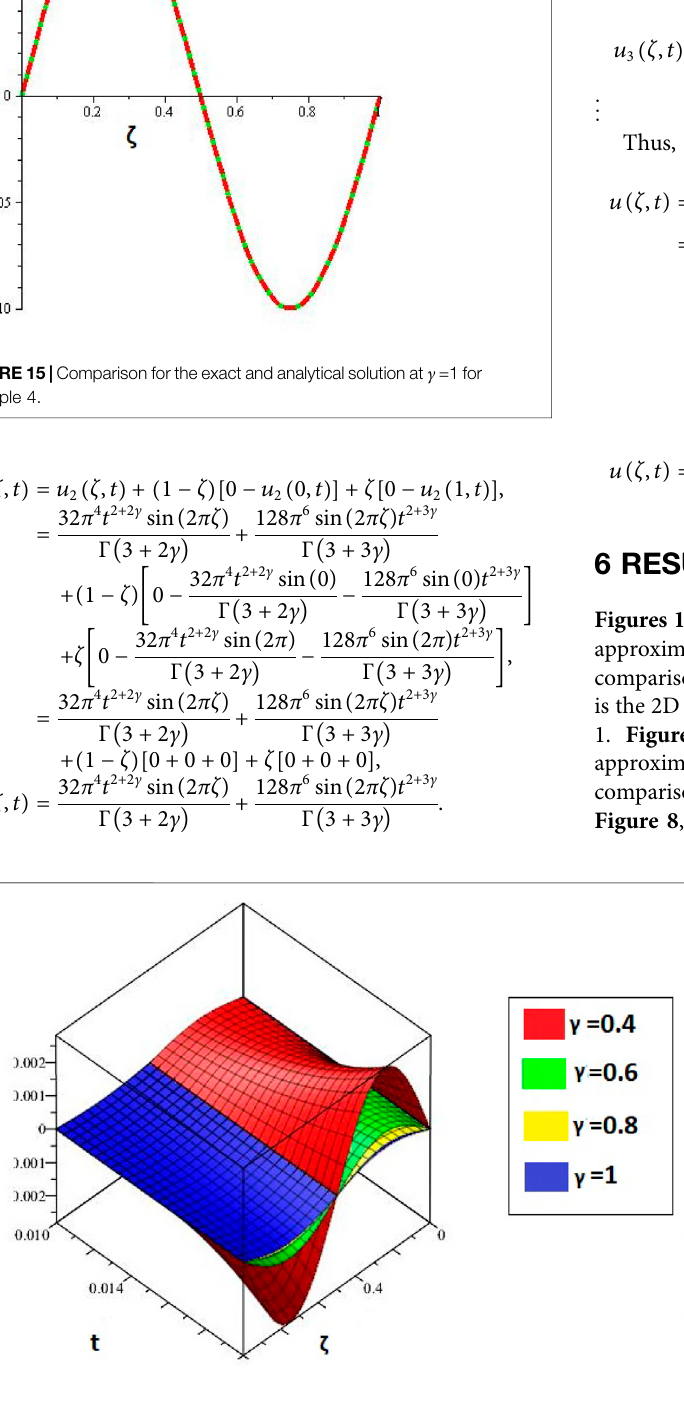
FIGURE 16 | 3D and 2D plots for the ADM solution at different values of γ for Example